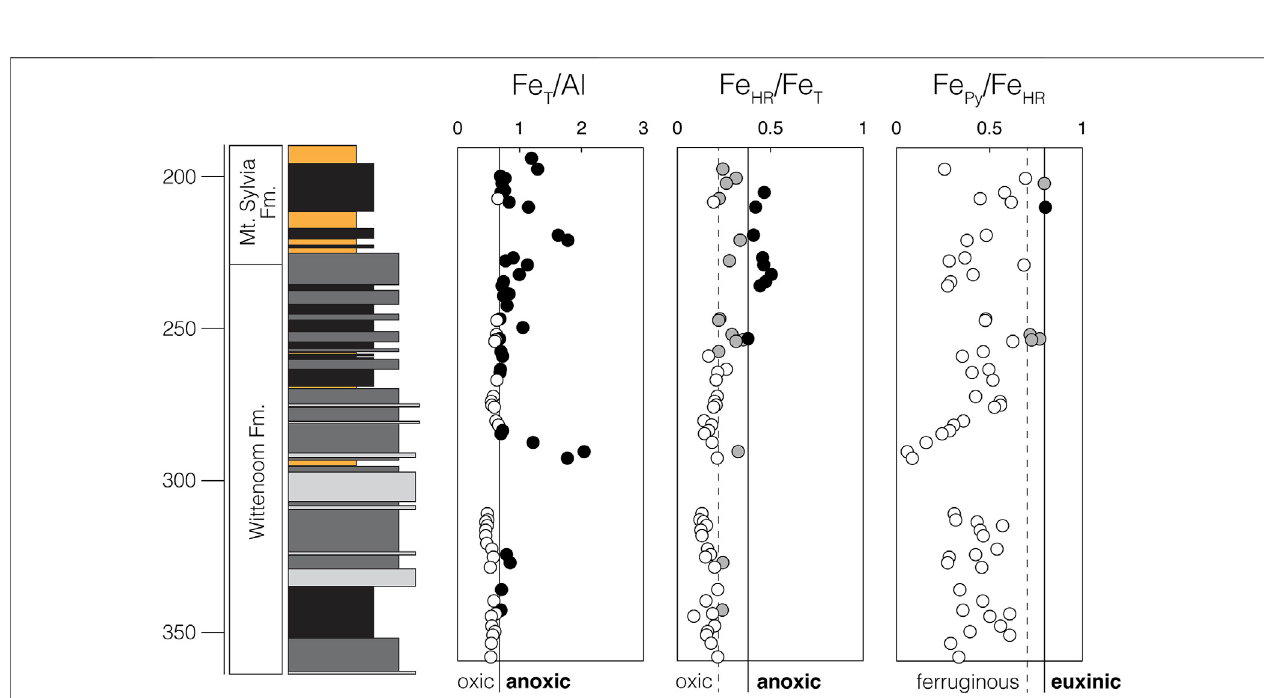
FIGURE 2| Previously published Fe speciation data indicating persistent localized anoxia during deposition ofthe Wittenoom and Mt. Sylvia formations in ABDP9. Data and original interpretation are from Ostrander et al. (2020). Black datapoints exceed strict thresholds for local anoxia (Fe T /Al > 0.55 or Fe HR /Fe T > 0.38) or euxinia (Fe Py /Fe HR > 0.80), while gray datapoints exceed relaxed thresholds for the same (Fe HR /Fe T > 0.22 for anoxia and Fe Py /Fe HR > 0.70 for euxinia) (summarized in Raiswell et al., 2018).